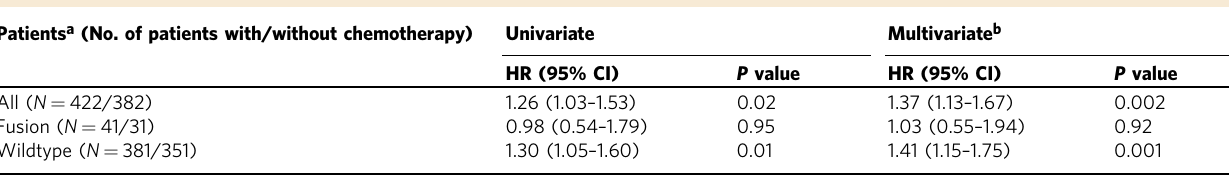
Table 2 Impact of CLDN18-ARHGAP26/6 fusion on chemotherapy treatment outcomes Patients a (No. of patients with/without